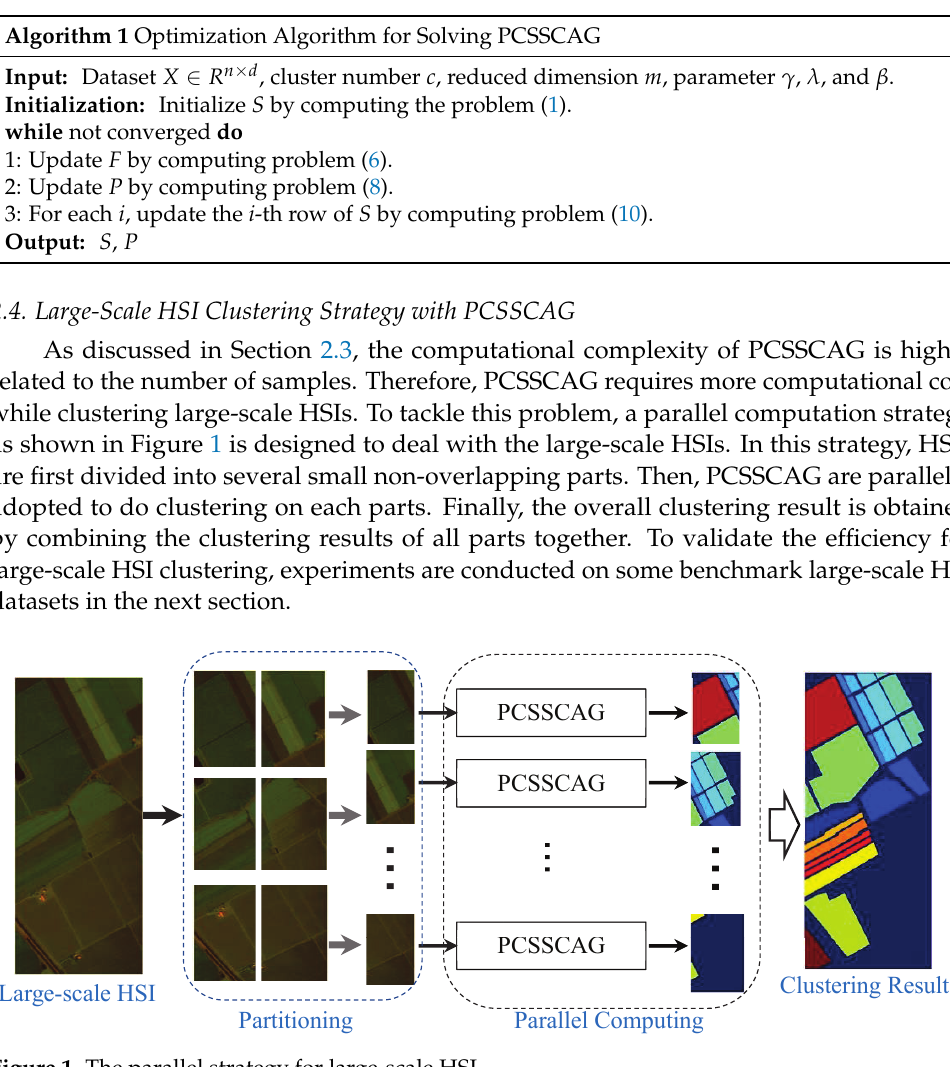
Figure 1. The parallel strategy for large-scale